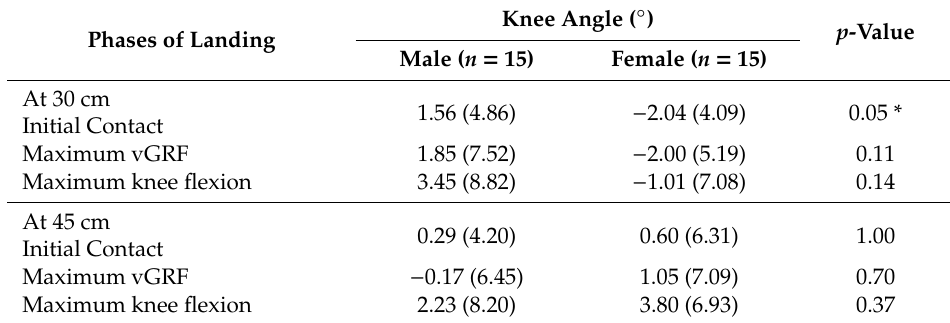
Table 2. Knee angle during phases of landing from 30 cm and 45 cm heights across male and female university athletes ( n = 30).